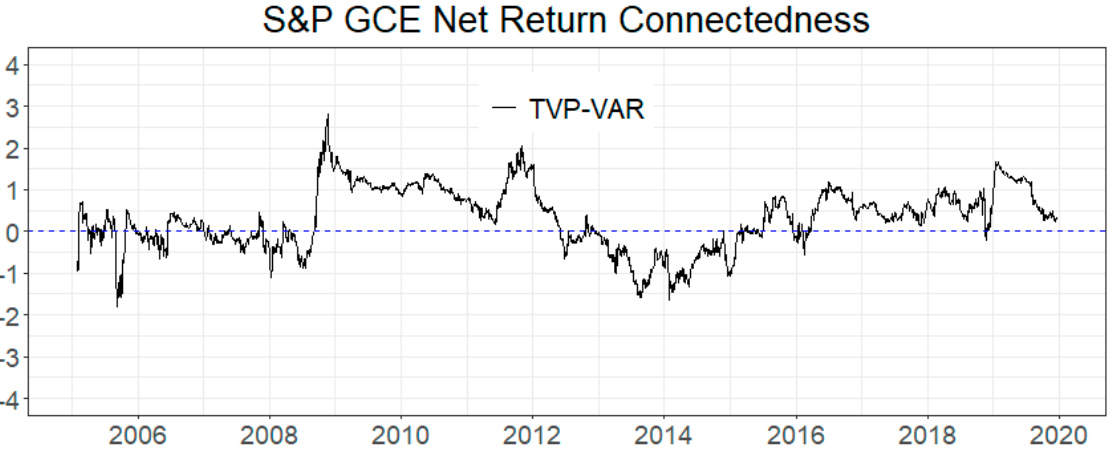
Figure 8. Dynamic net return connectedness. Note: the horizontal axis is the timeline; the vertical axis is the connectedness.